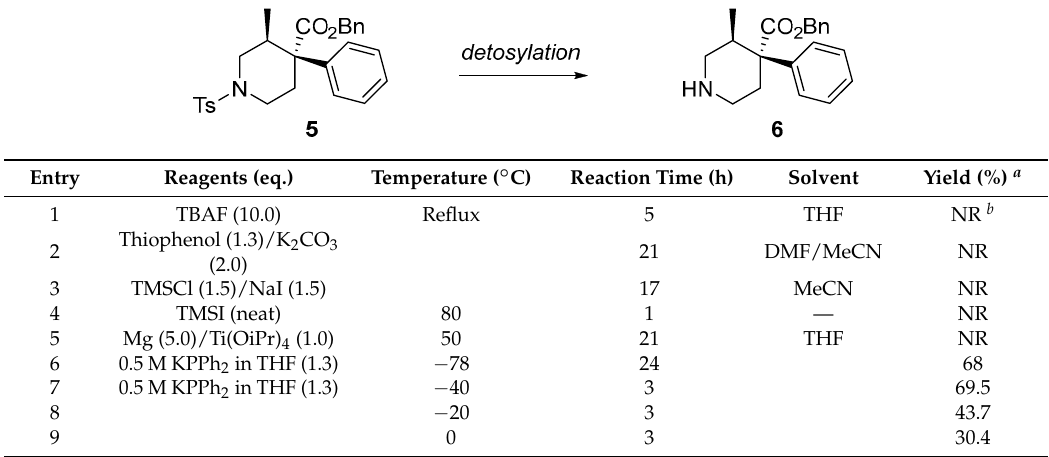
Table 2. Convenient detosylation of intermediate 5 .